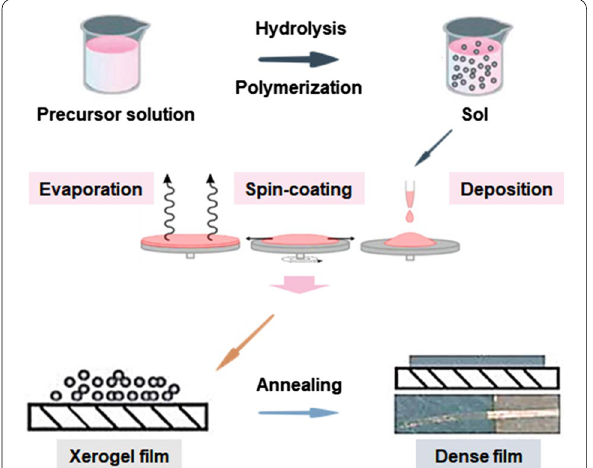
Fig. 6 Schematic illustration of spin-coating process [67] Copyright 2019 IOP Publishing